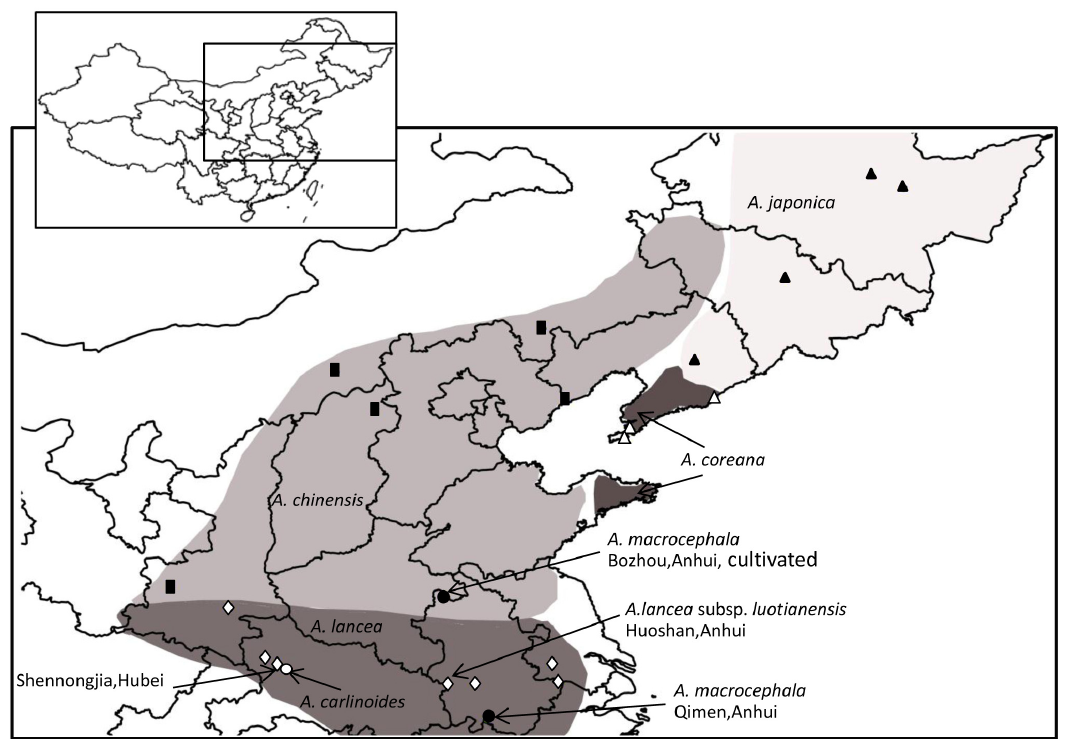
Figure 2. Geographic distribution of Atractylodes and sample collection location in China ( ▲ : A.japonica ; █ : A.chinensis ; ∆ : A. coreana ; ◊ : A. lancea or A.lancea subsp luotianensis ; ● : A. macrocephala ; ○ : A. carlinoides